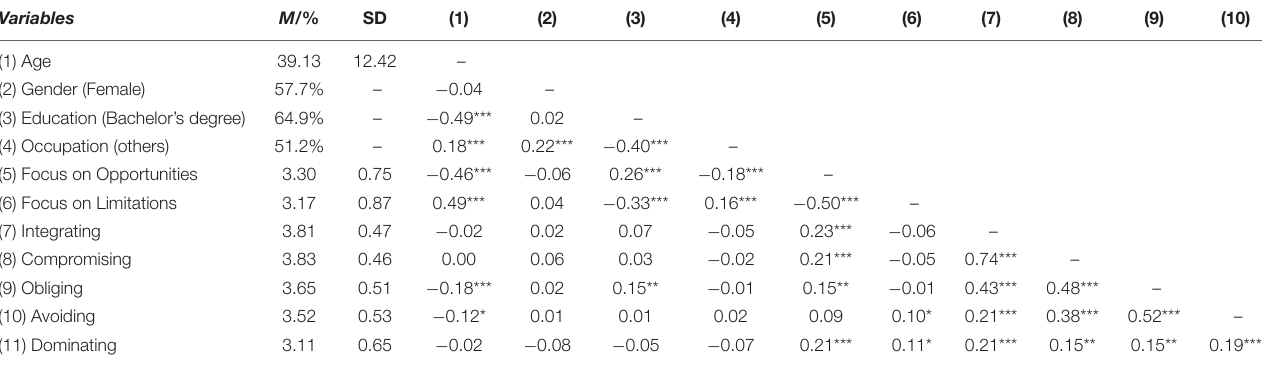
TABLE 1 | Descriptive statistics and correlation among major variables in Study 1 ( N = 416).